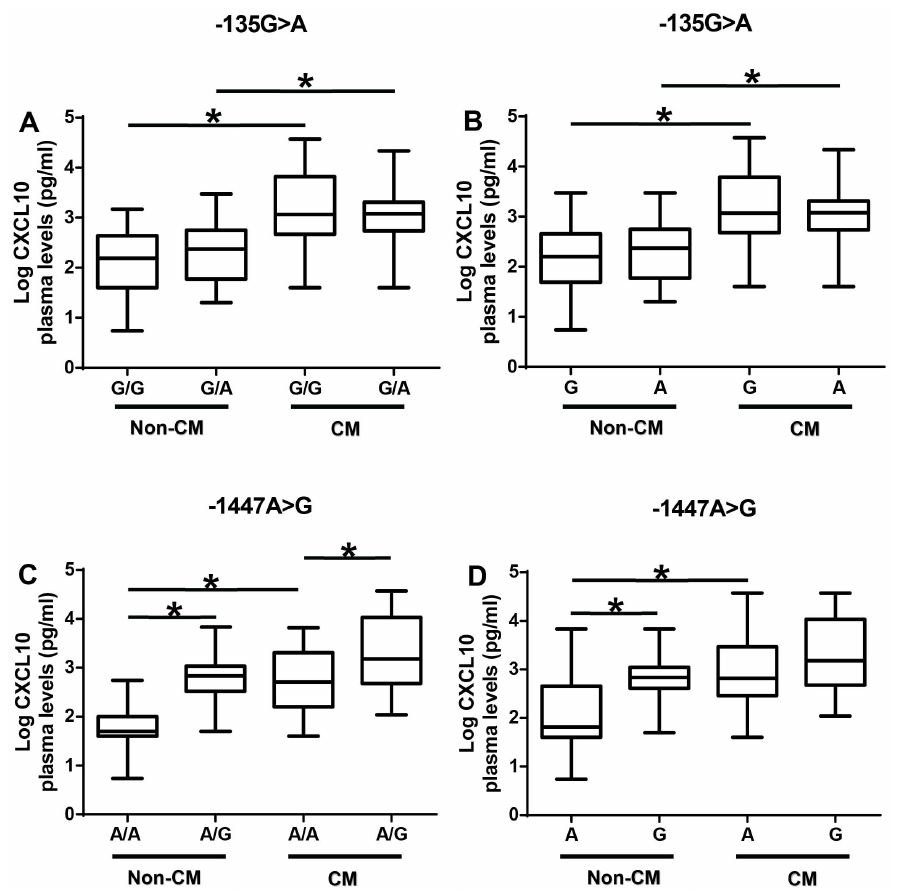
Figure 3. Association between 2 135G . A and 2 1447A . G polymorphism with plasma CXCL10 levels stratified by disease group. (A) Effect of 2 135G . A polymorphism genotype on plasma CXCL10 protein levels stratified by disease group. (B) Effect of 2 135G . A polymorphism allele on plasma CXCL10 protein levels stratified by disease group. (C) Effect of 2 1447A . G polymorphism genotype on plasma CXCL10 protein levels stratified by disease group. (D) Effect of 2 1447A . G polymorphism allele on plasma CXCL10 protein levels stratified by disease group. Box plot represent log-transformed medians with 25 th and 75 th percentiles, bars for 10 th and 90 th percentiles. The distribution of plasma CXCL10 expression levels among non-CM and CM patients segregated according to the genotype was analyzed with the Kruskal-Wallis test, followed by a Dunn’s multiple-comparison, with p , 0.05 considered significant. Asterisk (*) indicates a significant difference (p , 0.05).